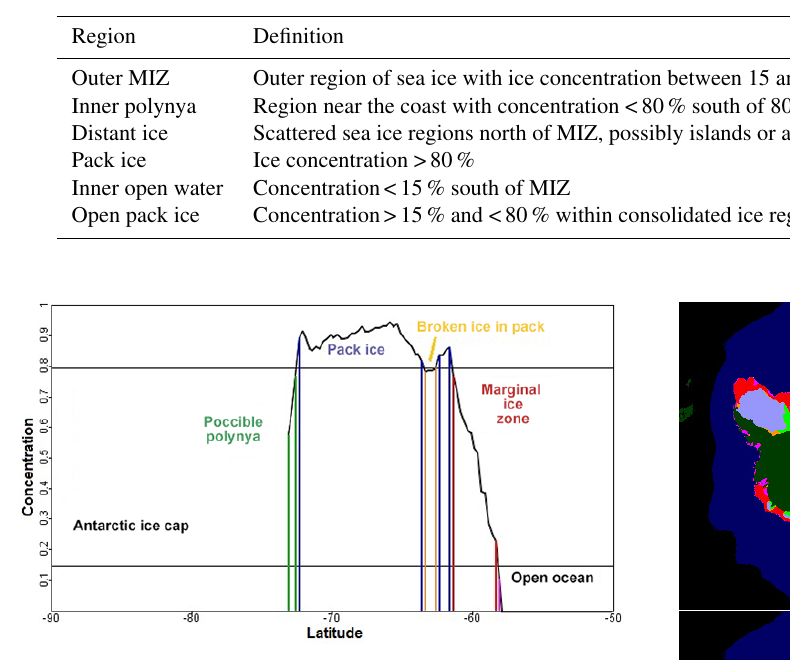
Figure 1. Example of a radial profile from 50 to 90 ◦ S at − 11.60 ◦ W on 3 September 1990, showing the different sea ice classifications found along this transect.